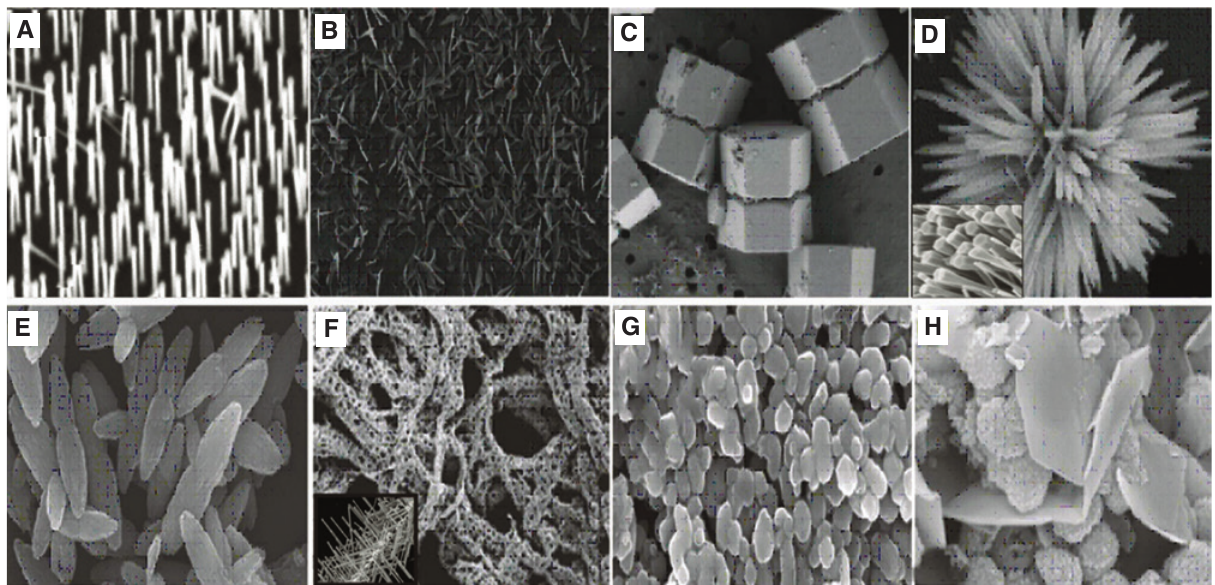
Figure 2: ZnO electron microscopic nanostructures: (A) needles, rods, and wires; (B) helixes and springs; (C) nanopellets/nanocapsules; (D) flower, snowflakes, and dandelion; (E) peanut-like; (F) interwoven particle hierarchy; (g) raspberry, nanosheet/nanoplate; (H) circular/round or sphere shaped [1–3].